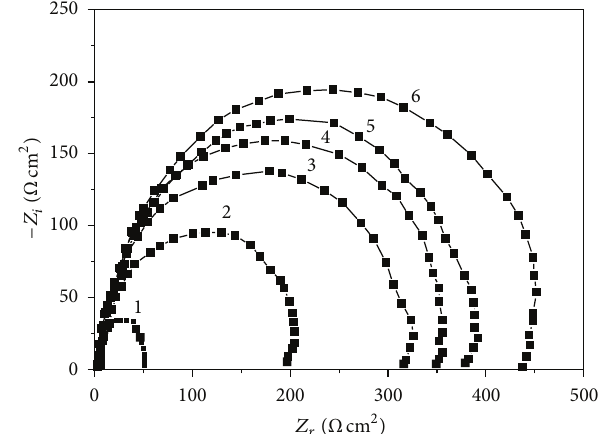
Figure 8: Nyquist plots for zinc electrode in 1.0 M HCl in absence and presence of different concentrations of Marjoram extract: (1) 0.00 ppm, (2) 100ppm, (3) 200 ppm, (4) 300 ppm, (5) 400 ppm, and (6) 500